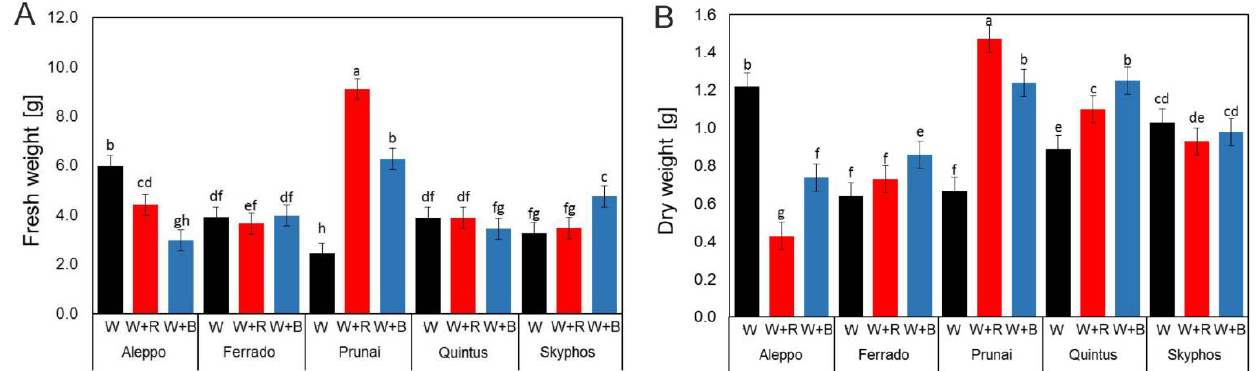
Figure 2. The fresh ( A ) and dry weight ( B ) of lettuce seedlings grown under different light treatment (W—white light, W + R—white and red light, W + B—white and blue light). Different letters for the same parameter indicate significant differences at the 5% level, according to the Newman–Keuls’s test. The bars represent the standard deviation.